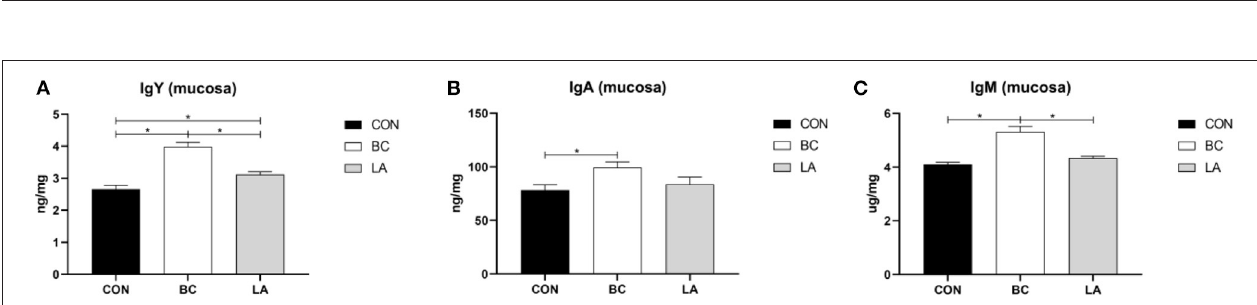
FIGURE 4 | (A–C) Effects of probiotics on jejunal mucosa immunoglubins induced by lipopolysaccharide in broilers. CON, broilers were not treated except for the base diet; BC, broilers were supplemented with Bacillus coagulans ; LA, broilers were supplemented with Lactobacillus plantarum ; “ * ” means significantly difference. N =